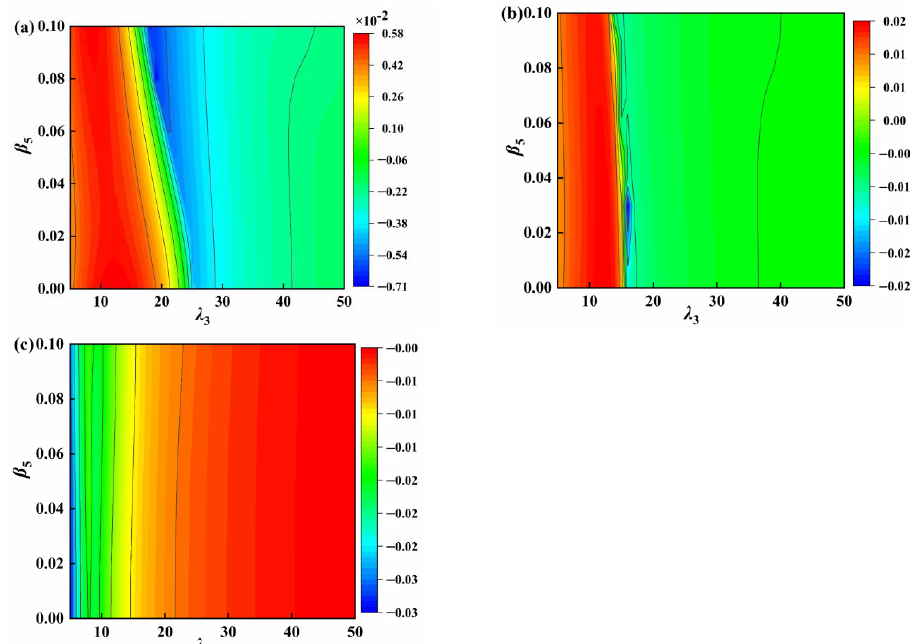
Figure 9. The resonant frequency change of the primary system as negative stiffness ratio β 5 and inertance ratio λ 3 under f e = 0.4 mm: ( a ) β 3 = 0.0027; ( b ) β 3 = 0.027; ( c ) β 3 = 0.27.